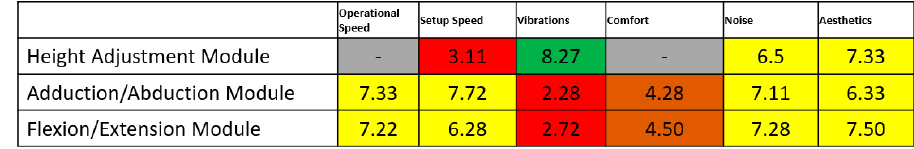
Figure 12. Scores obtained by each